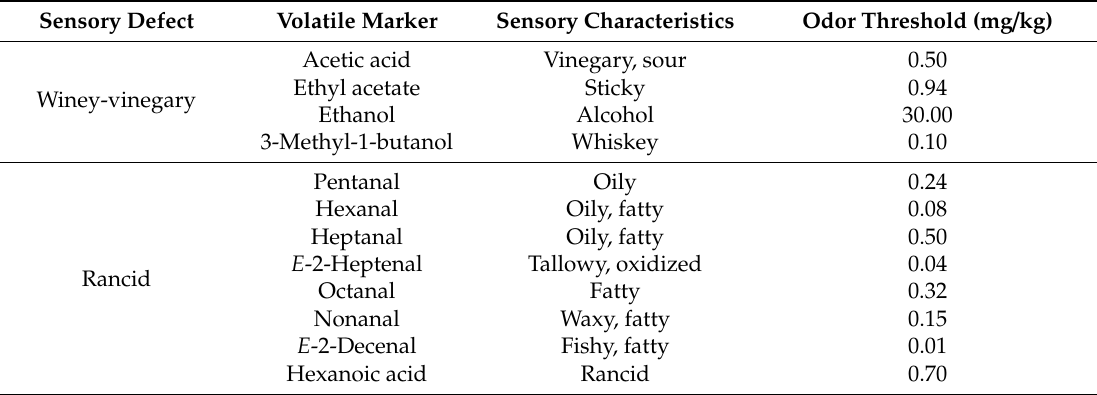
Table 1. Volatile markers of VOO sensory defects winey-vinegary and rancid, sensory characteristics and corresponding odor threshold relating to an oil